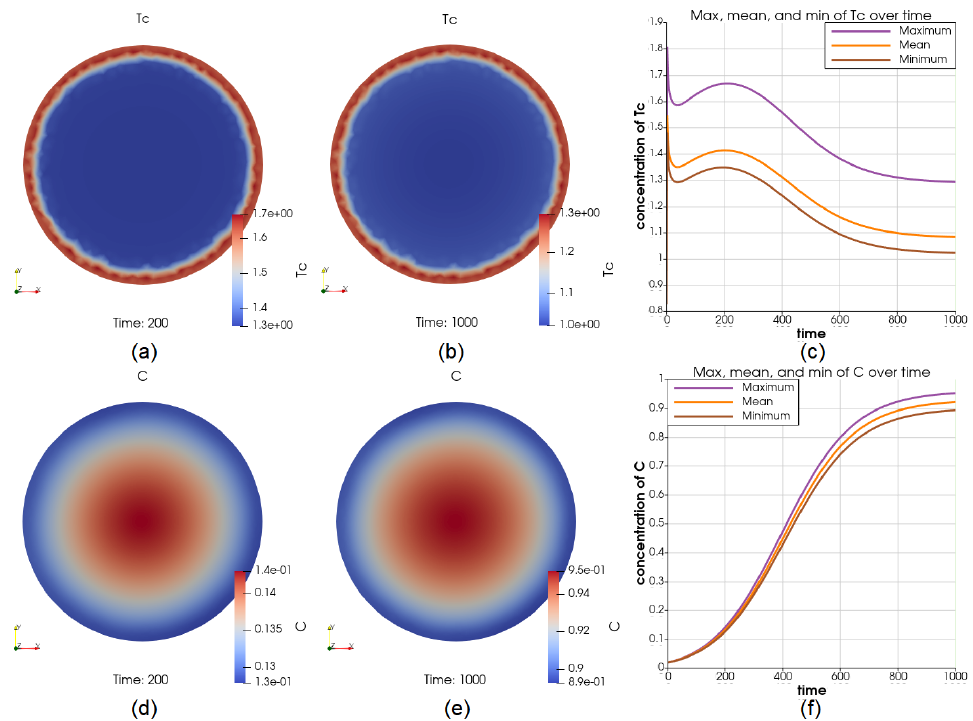
Figure 9. Illustrations for the case of a constant source of T c on the boundary. Su-figures ( a , b ) shows the value of T c at t = 200 and t = 1000, respectively; ( c ) shows the dynamics of the maximum and minimum of T c , depicting that the value of T c on the boundary is constantly higher than it is elsewhere; the cancer cell concentration at t = 200 and t = 1000 are shown in ( d , e ); the value of the maximum and minimum of C over the whole time interval is shown in ( f ), where the growth of cancer cells, especially near the boundary, are inhibited strongly by the higher concentration of T c